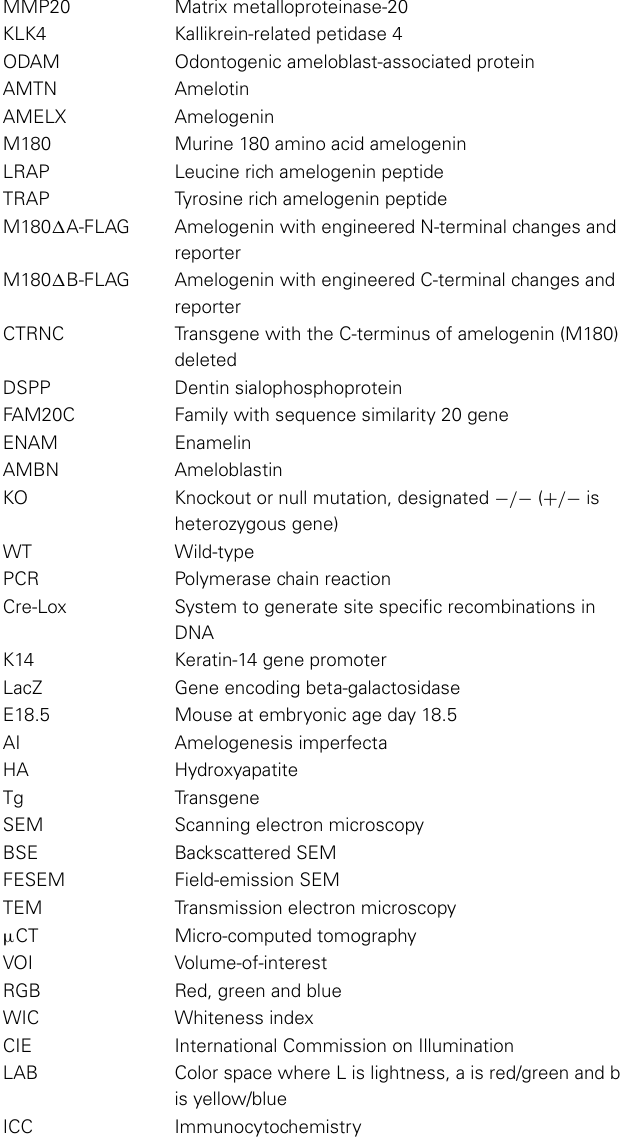
Table 1 | List of